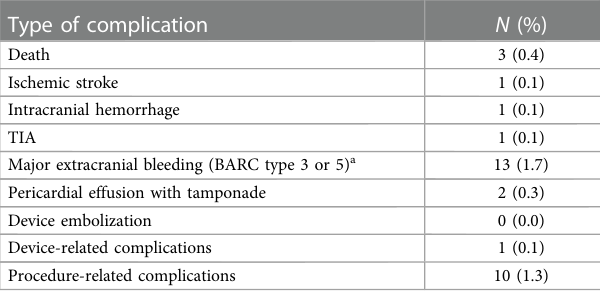
TABLE 3 Peri-procedural complications ( N 772).